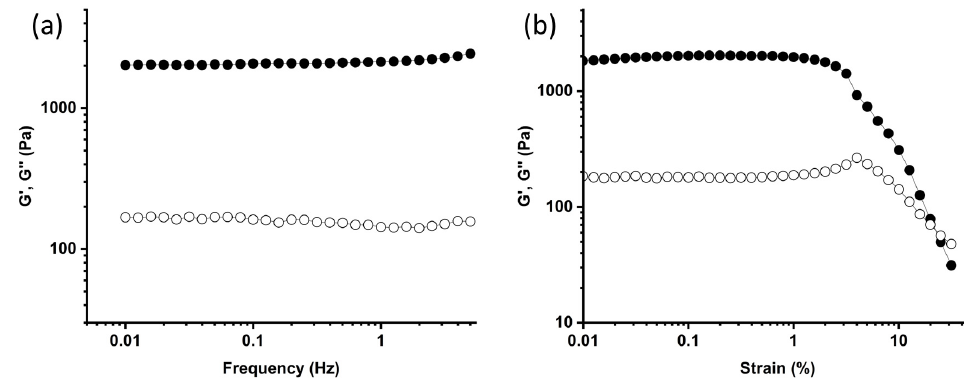
Figure 2. ( a ) Frequency sweep experiment and ( b ) strain sweep experiment of gel at 0.5 wt % concentration; fi lled circles represent G ′ while open circles represent G ″